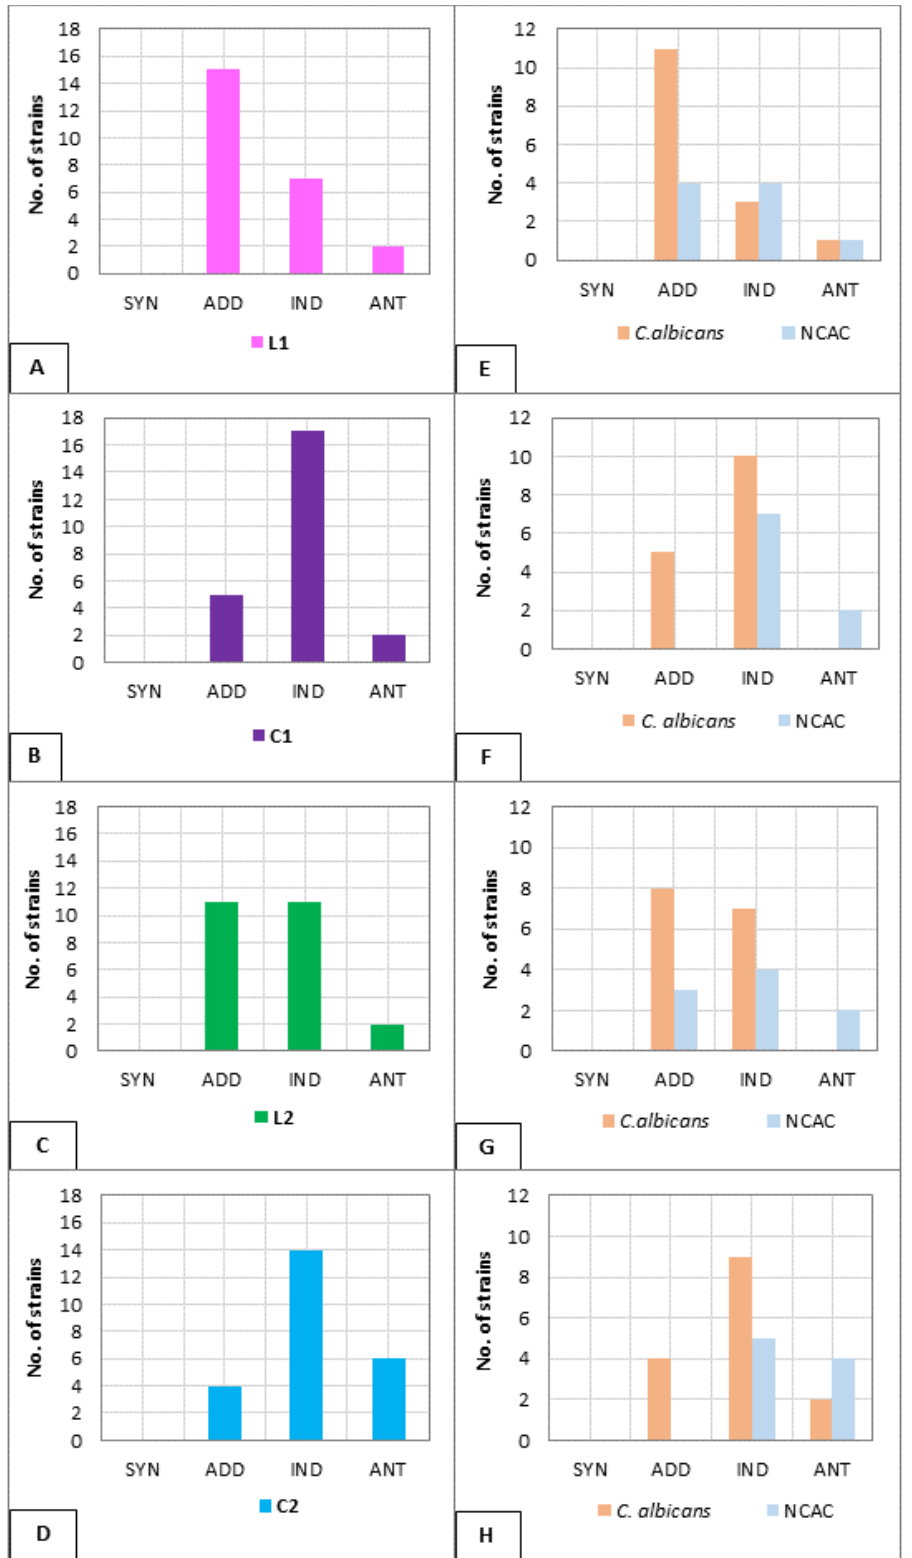
Figure 3. Interpretation of the determined FIC indices (SYN—synergy, ADD—addition, IND—indifference, ANT—antagonism): ( A ) L1; ( B ) C1; ( C ) L2; ( D ) C2; and with differentiation between C. albicans and NCAC isolates: ( E ) L1; ( F ) C1; ( G ) L2; ( H ) C2.